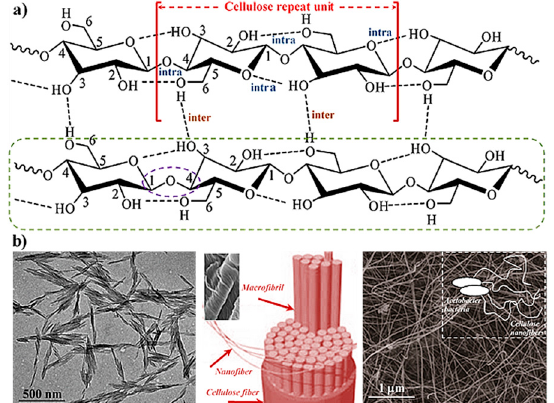
Figure 1. ( a ) Scheme of the linear molecular chain (green box), the syndiotactic repeat unit (garnet), the establishment of glycosylic bonds between glucose rings (violet ellipsoid) and intra and intermolecular hydrogen bonding interactions; ( b ) TEM micrograph of cellulose nanowhiskers (left), scheme and SEM micrograph of nanofibers derived from a fiber of cellulose (middle) and TEM micrograph of bacterial cellulose (right). Reproduced with permission from [19], copyright 2007 ACS; and reproduced from [20].